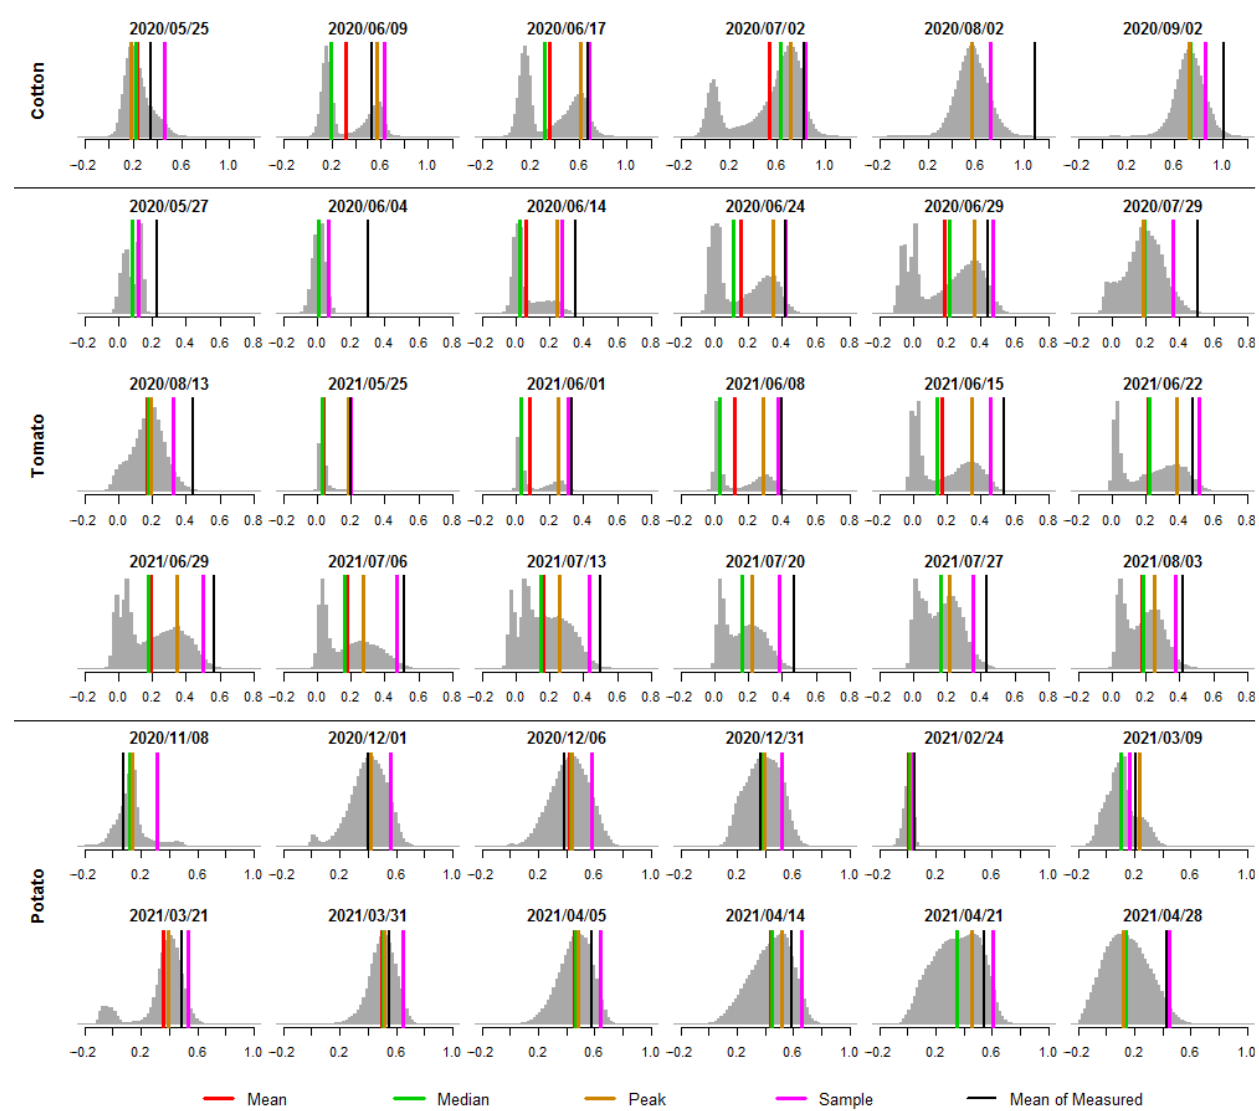
Figure 4. Histograms of crop height models (CHMs) pixel values in the large ROI, marked with the calculated height values from four methods and the mean of the manual measurements.